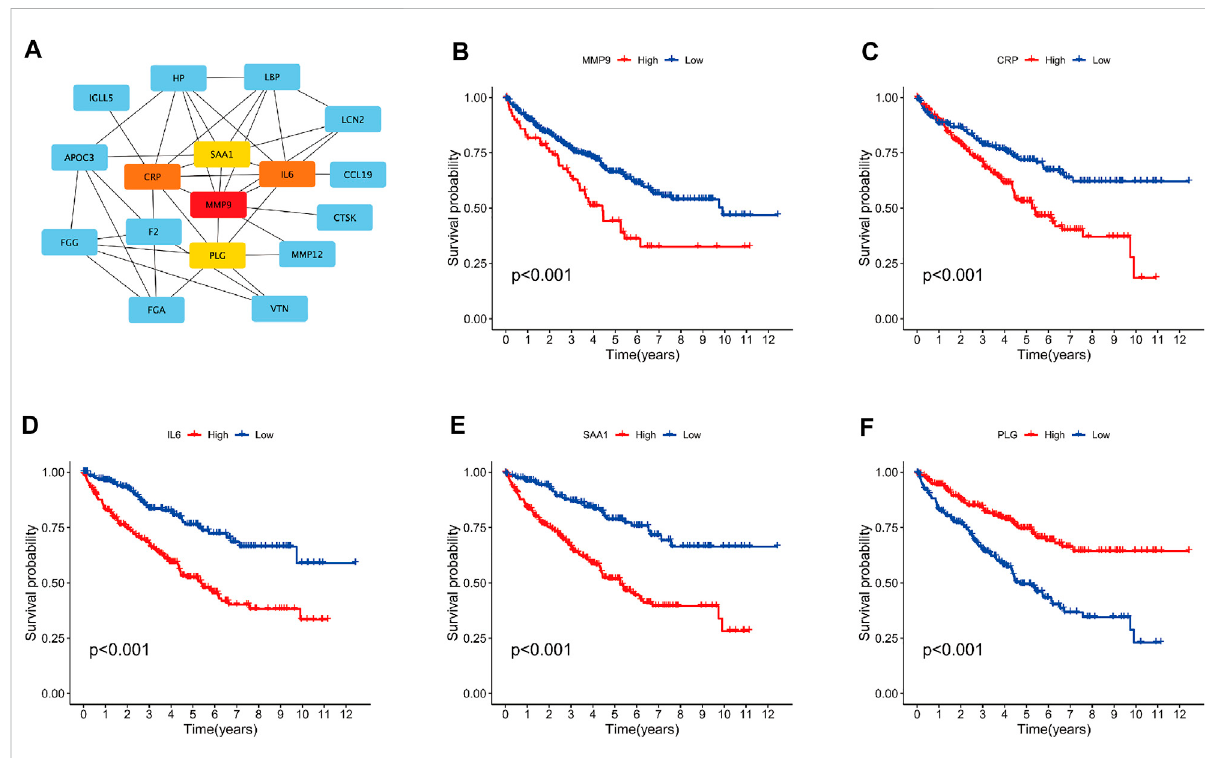
FIGURE 5 (A) Graph of hub gene relationships among SAGRI subgroups; (B – F) : survival curve of hub genes in TCGA